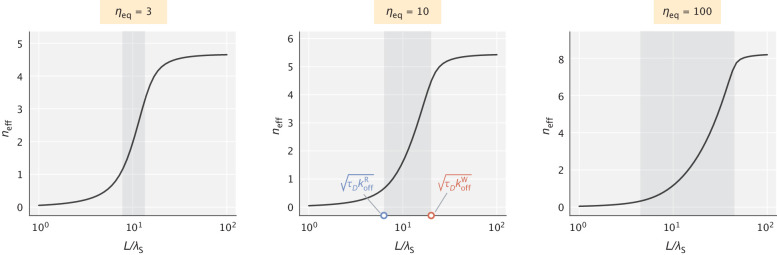
The effective number of proofreading realizations (neff) as a function of L/λS.The shaded region represents the range of L/λS values set by the key dimensionless numbers τD⁢koffR and τDkoffW. τD values chosen for the demonstration were 60, 40, and 20 (in 1/koffR units) for the three different choices of ηeq, respectively.